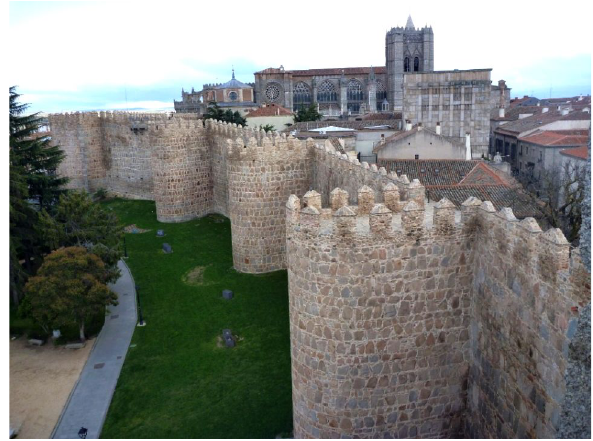
Figure 3. View from the terrace of cube 8 of sections 4-5-6-7-8 and cubes 4, 5, 6 and 7, in